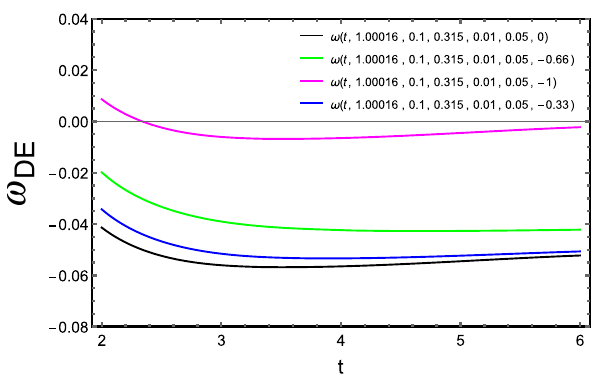
Fig. 3 DE EoS parameter vs. time for different viscous coefficients